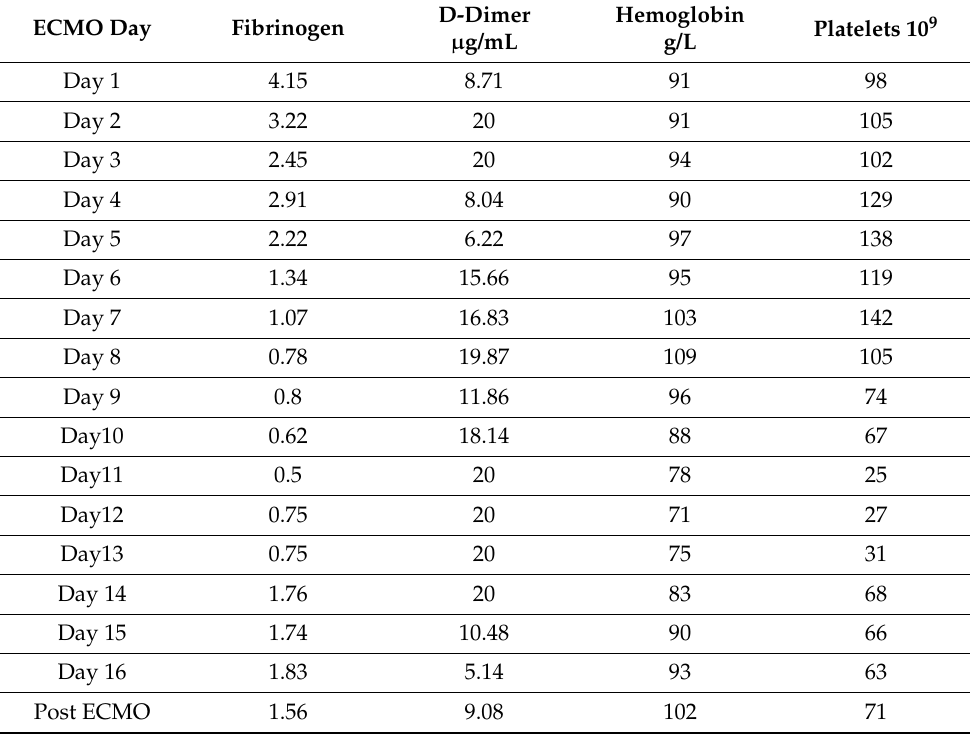
Table 1. Coagulation results Day1 until post-ECMO